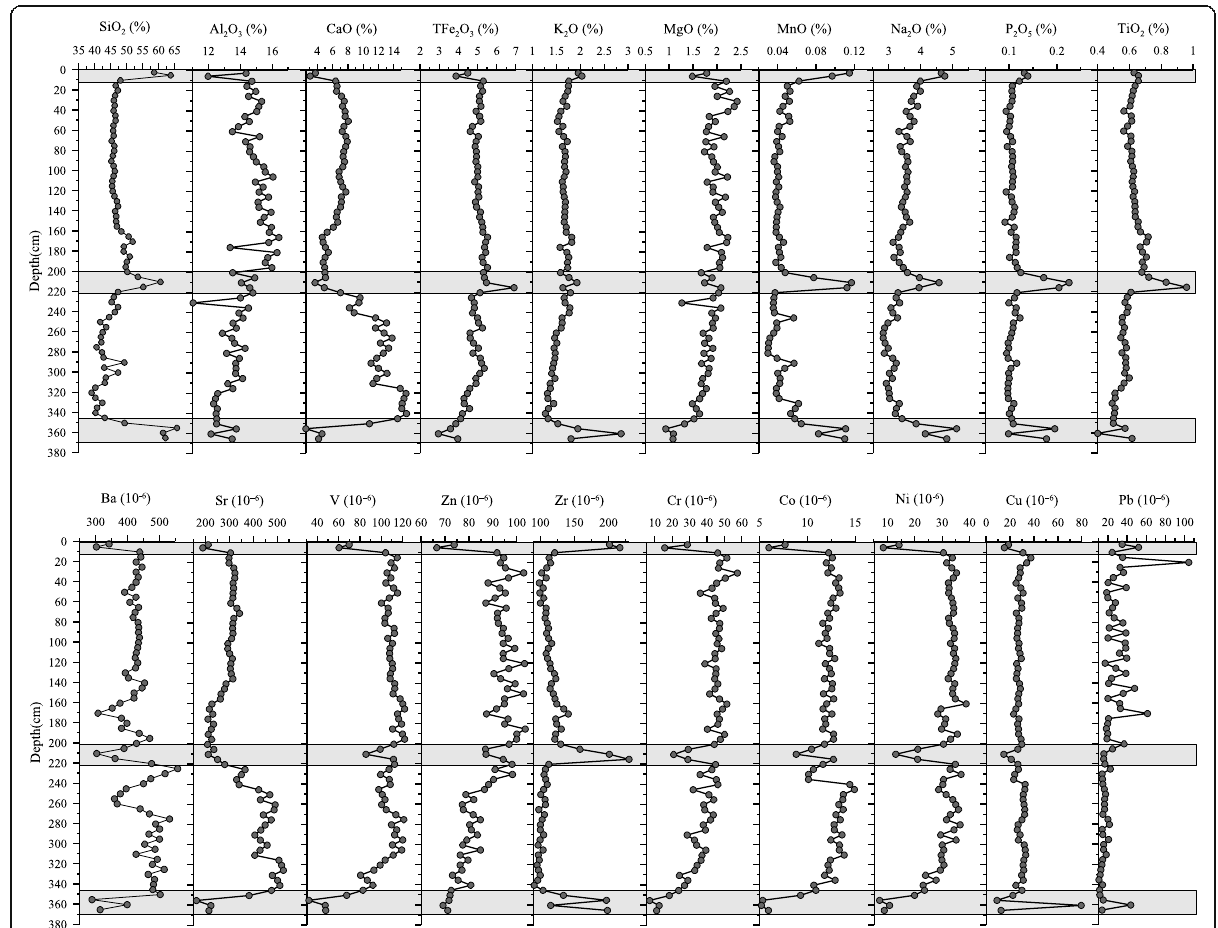
Fig. 3 Vertical distributions of major and trace elements of core SO184-10043; gray belts (at the depth of 0 – 12.0 cm, 200 – 222 cm, and 350 – 370 cm) represent the layers with largest geochemical fluctuation